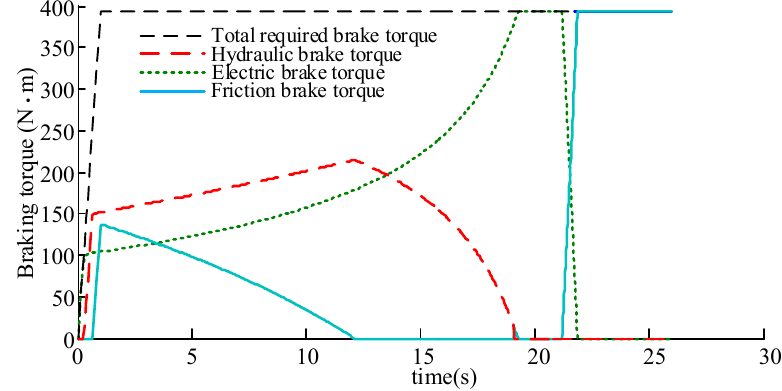
Figure 13. Braking torque distributions and their distribution in the front axle.